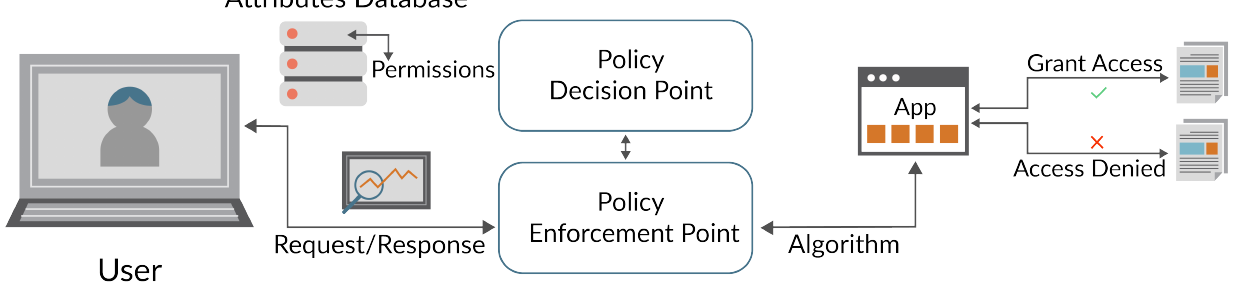
Figure 3. Data access